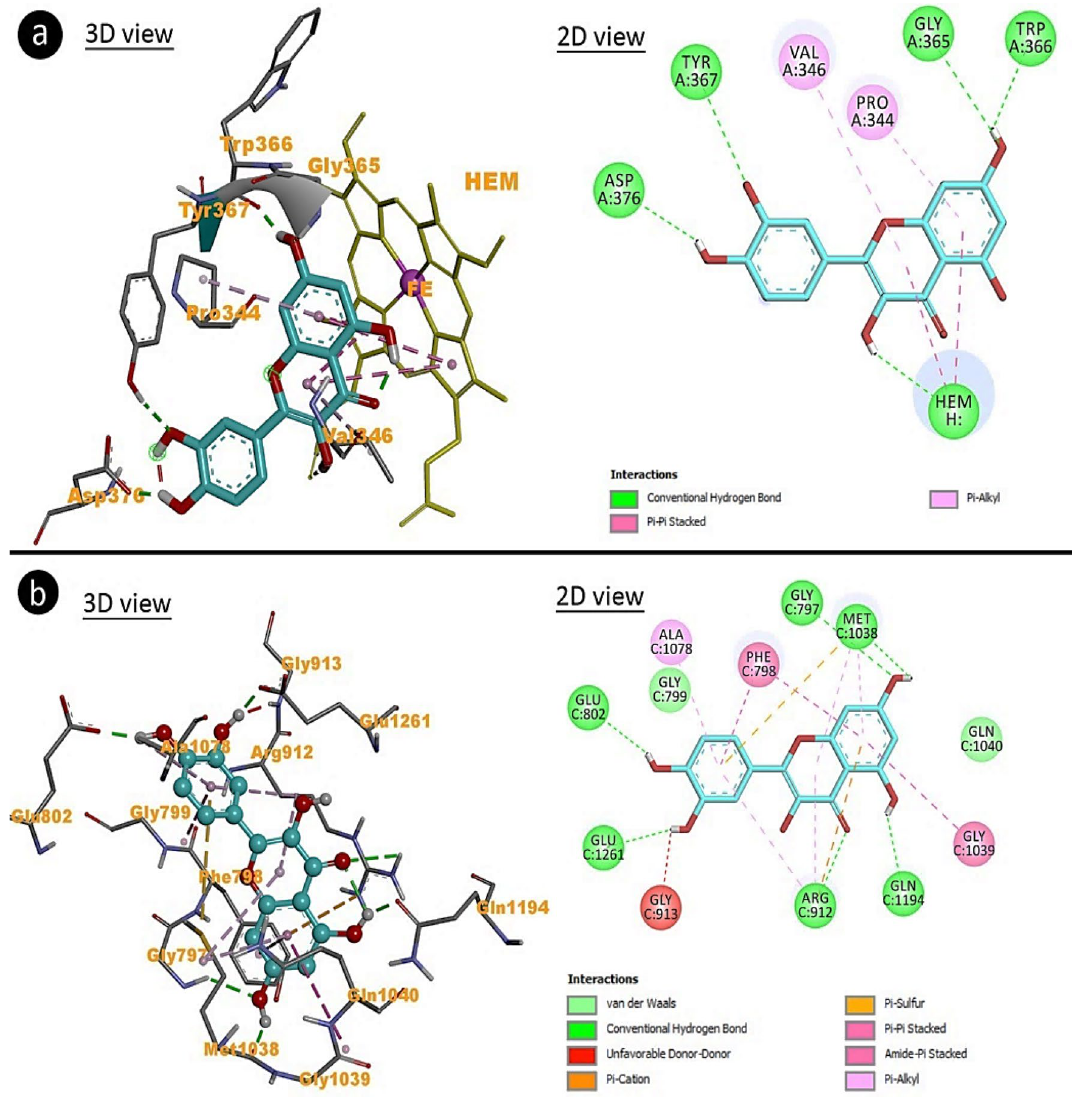
Figure 8. Molecular docking of AFM 2 -NOs ( a ) and AFM 2 -XO ( b